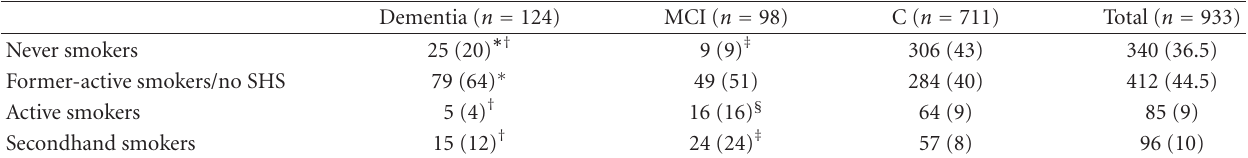
Table 2: Cognitive levels and smoking